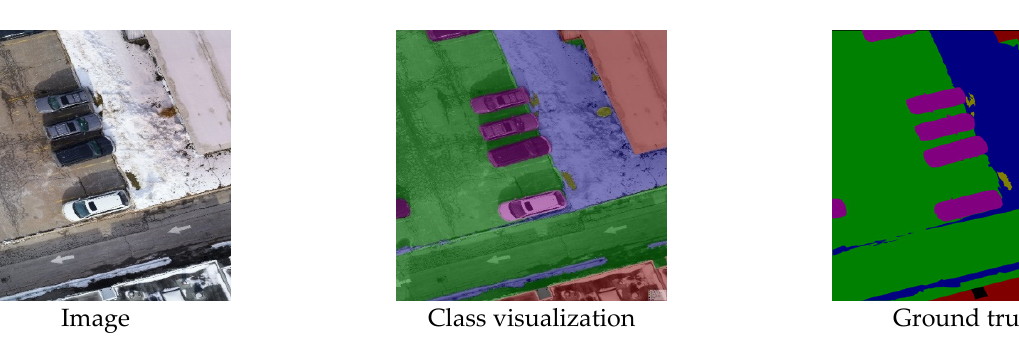
Figure 13. False-color combination of the RGB + LiDAR case for the first test site.